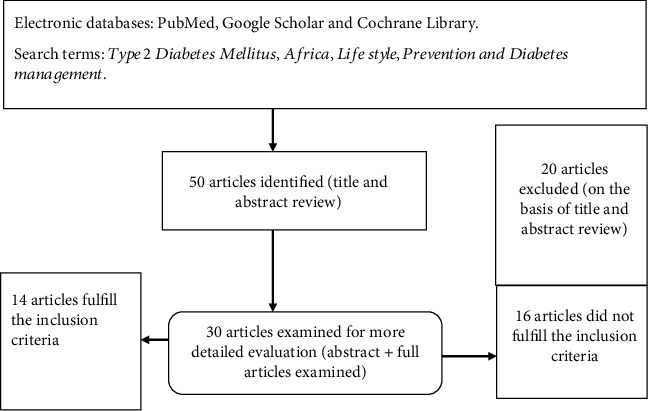
Diagram showing electronic databases, articles search, inclusion criteria, and selection process.